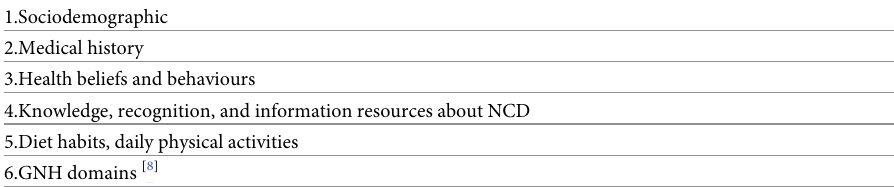
Table 1. Topics of interview and observation.